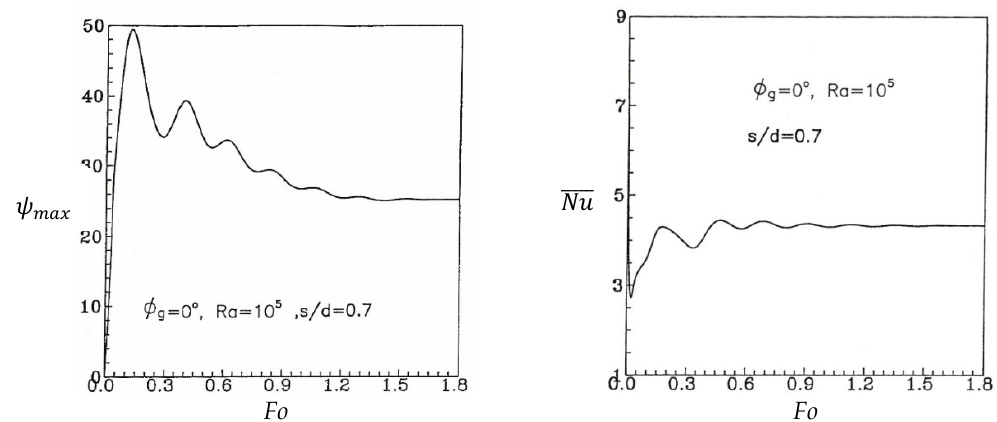
Figure 8. Variation in the maximum stream function ( left ) and average Nusselt number ( right ) of cold and hot cylinders versus time (Ra = 10 5 ) ( φ g = 0 ◦ , Ra = 10 5 and s / d = 0.7) [13].